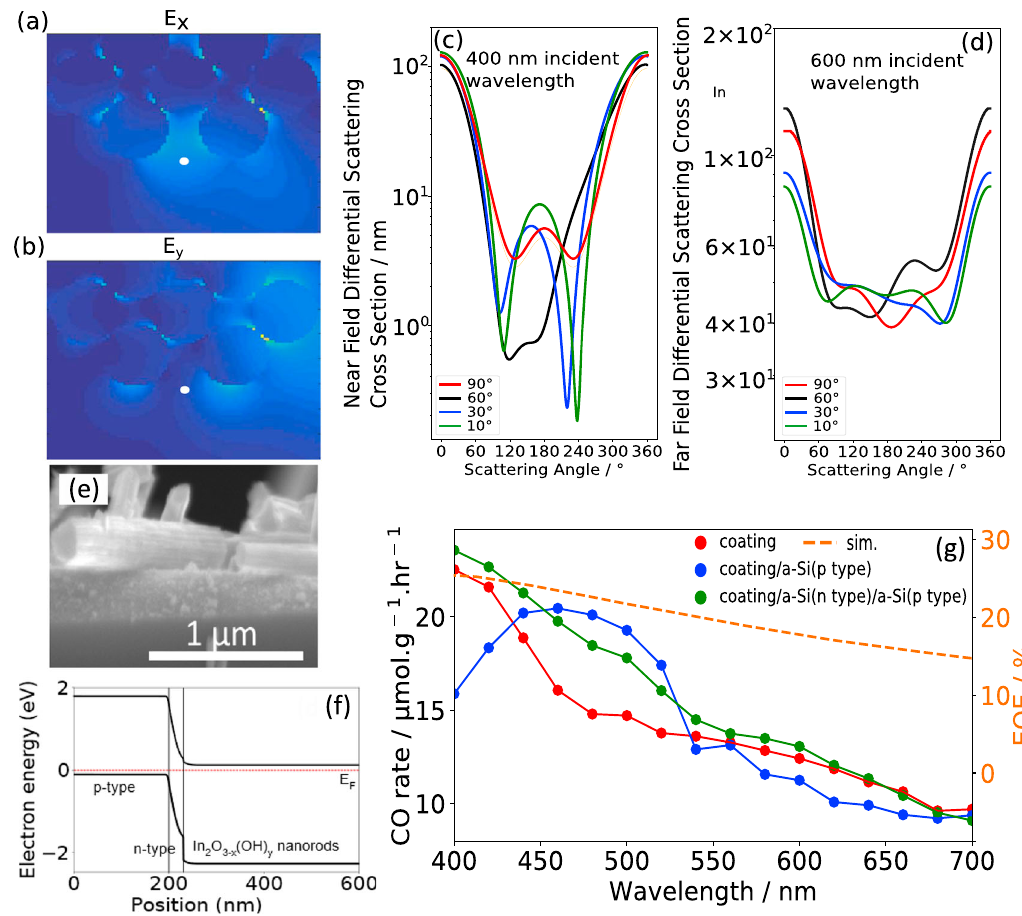
Fig. 4 Nanorod optical scattering. a , b The optical Mie scattering simulations of an array of cylindrical rods with refractive index of indium oxide at 400 and 500 nm incident wavelength. The array of cylindrical rods of 60 nm diameters near the scatterer point is shown, as marked by the white dot, under a plane wave at an incident angle of 30° to the x -axis. The scattering intensity plots under the a E x and E y b components of the incident plane wave are shown, respectively. c , d The near fi eld and far- fi eld scattering cross-sections at a range of scattering angles under several incident angles from 90° to 10° from the positive x -axis plane with 400 and 600nm wavelengths, respectively. e SEM cross-sectional images of nanorods on 200 nm p-type/40 nm n- type silicon layers. The white scale bar represents 1 µ m length. f Calculated equilibrium band diagram of p- type a-Si/ n type a-Si/In 2 O 3 − x (OH) y system. g Photo-action spectroscopy of quartz rod coated with In 2 O 3 − x (OH) y nanorods (red), nanorods on p -type amorphous silicon (blue), and nanorods on n